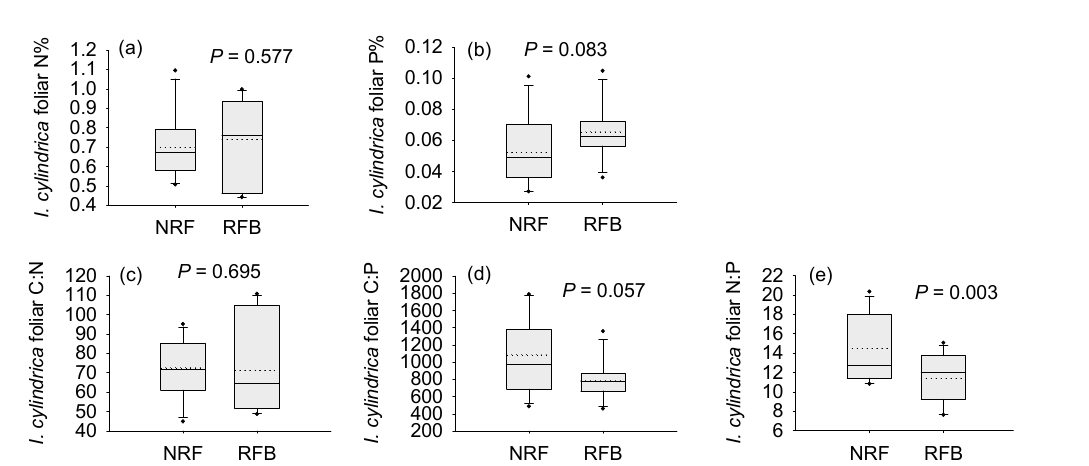
Figure 2. Correlations between ( a ) Imperata cylindrica foliar N content and foliar N:P ratios and ( b ) Imperata cylindrica foliar P content and foliar N:P ratios across the three study sites (Toohey Forest [circles], WRSMCE A [upward triangles], and WRSMCE B [downward triangles]) and across NRF [white-filled symbols] and RFB [grey-filled symbols] areas; Pearson’s correlation coefficient ( r ) and p -values are shown in each panel ( n = 22).